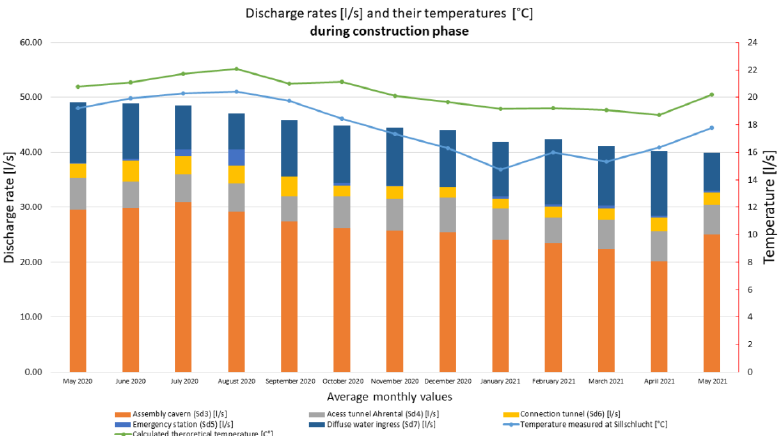
Figure 6. Discharge rates [L /s] (primary axis) in connection with the by the Richmann’s mixing rule calculated theoretical (green line) and the measured (blue line) temperature [°C] at the nothern por- tal of the BBT, Sill Gorge during